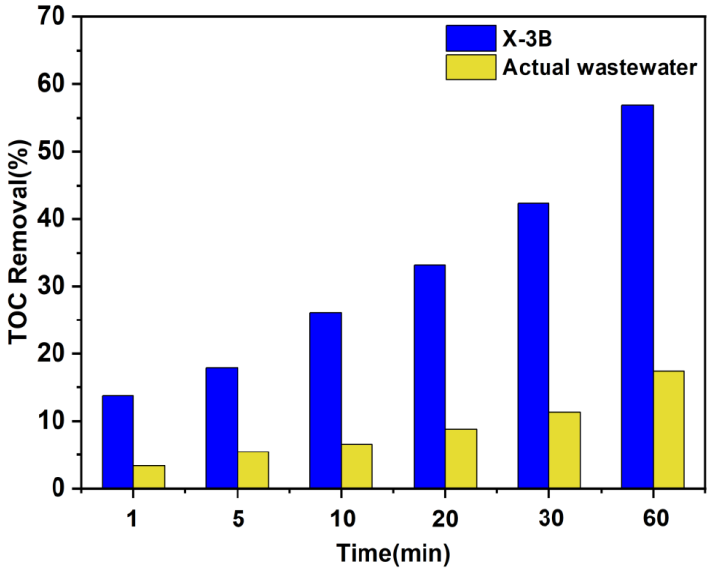
Figure 7. The total organic carbon (TOC) removal of X-3B and actual textile dyeing wastewater in a MAER UV–Fenton system. Reaction conditions: C 0, X-3B = 50 mg/L, TOC 0, actual = 78.0 mg/L, [H 2 O 2 ] = 150 mM, [Material] = 0.25 g/L, T = 25 °C, and pH with no adjustment.